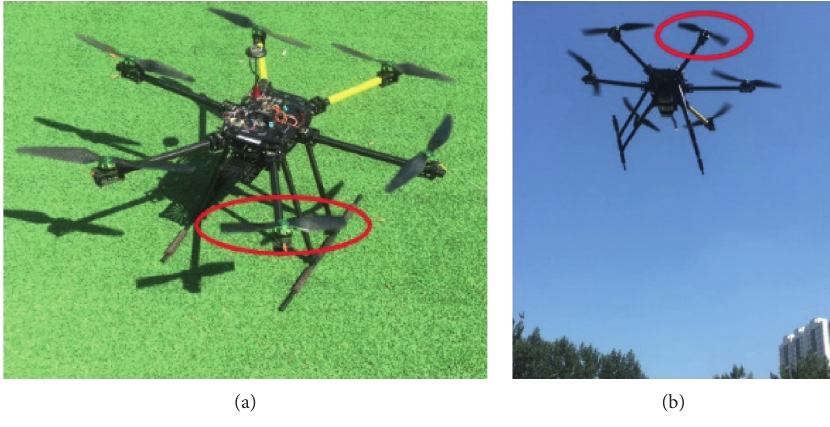
Figure 10: Actual flight